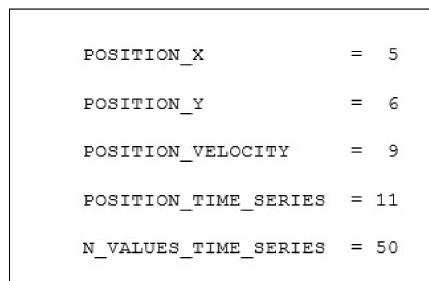
Figure 11. Example of an input shapefile read-map plain text